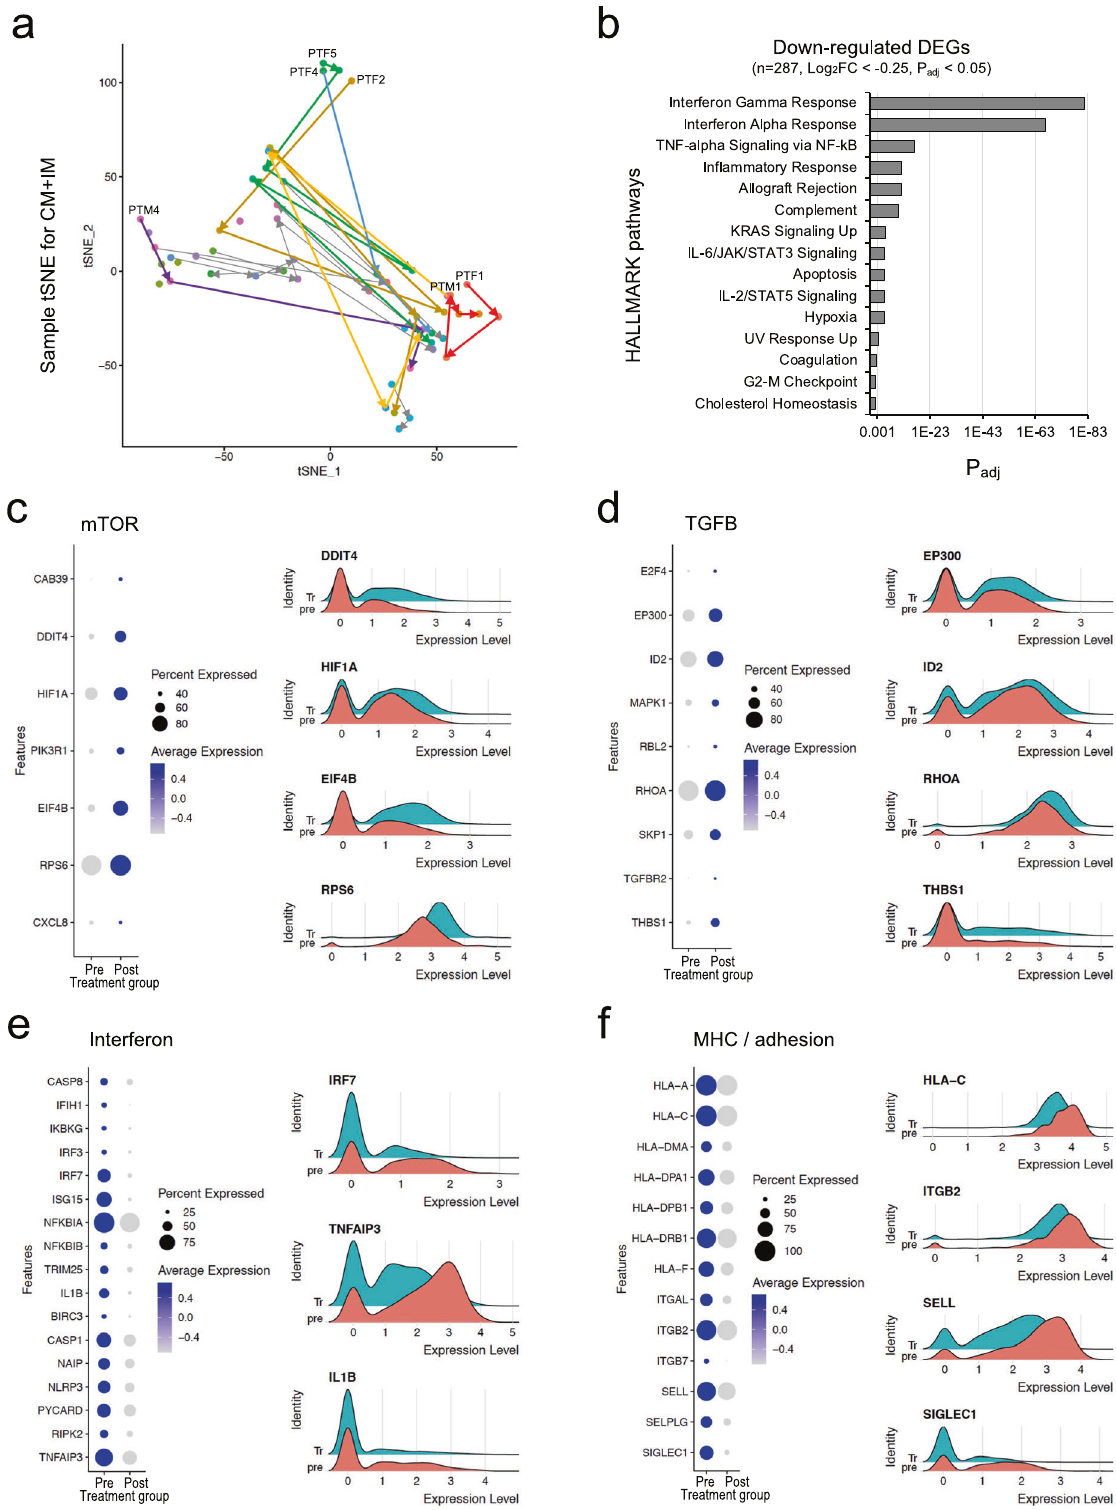
Fig. 3 Corticosteroid treatment suppresses the type-I IFN response in classical monocytes (CMs) and intermediate monocytes (IMs). a tSNE plot of pseudobulk gene expression values for CMs/IMs in each sample. Colors represent individual patients. Arrows indicate the progression of time. Six patients with a pretreatment sample are labeled with text. b HALLMARK pathway enrichment analysis of genes downregulated by corticosteroid treatment. Padj, adjusted P value. c – f Expression of genes related to key signaling pathways. Left, dot plots depicting the percentage of cells in which the gene was detected ( “ Percent Expressed ” ) and average expression level of the gene (scaled data) in each cluster (blue, “ Average Expression ” ). Right, ridge plots depicting the expression of genes changed between pre- and post- corticosteroid